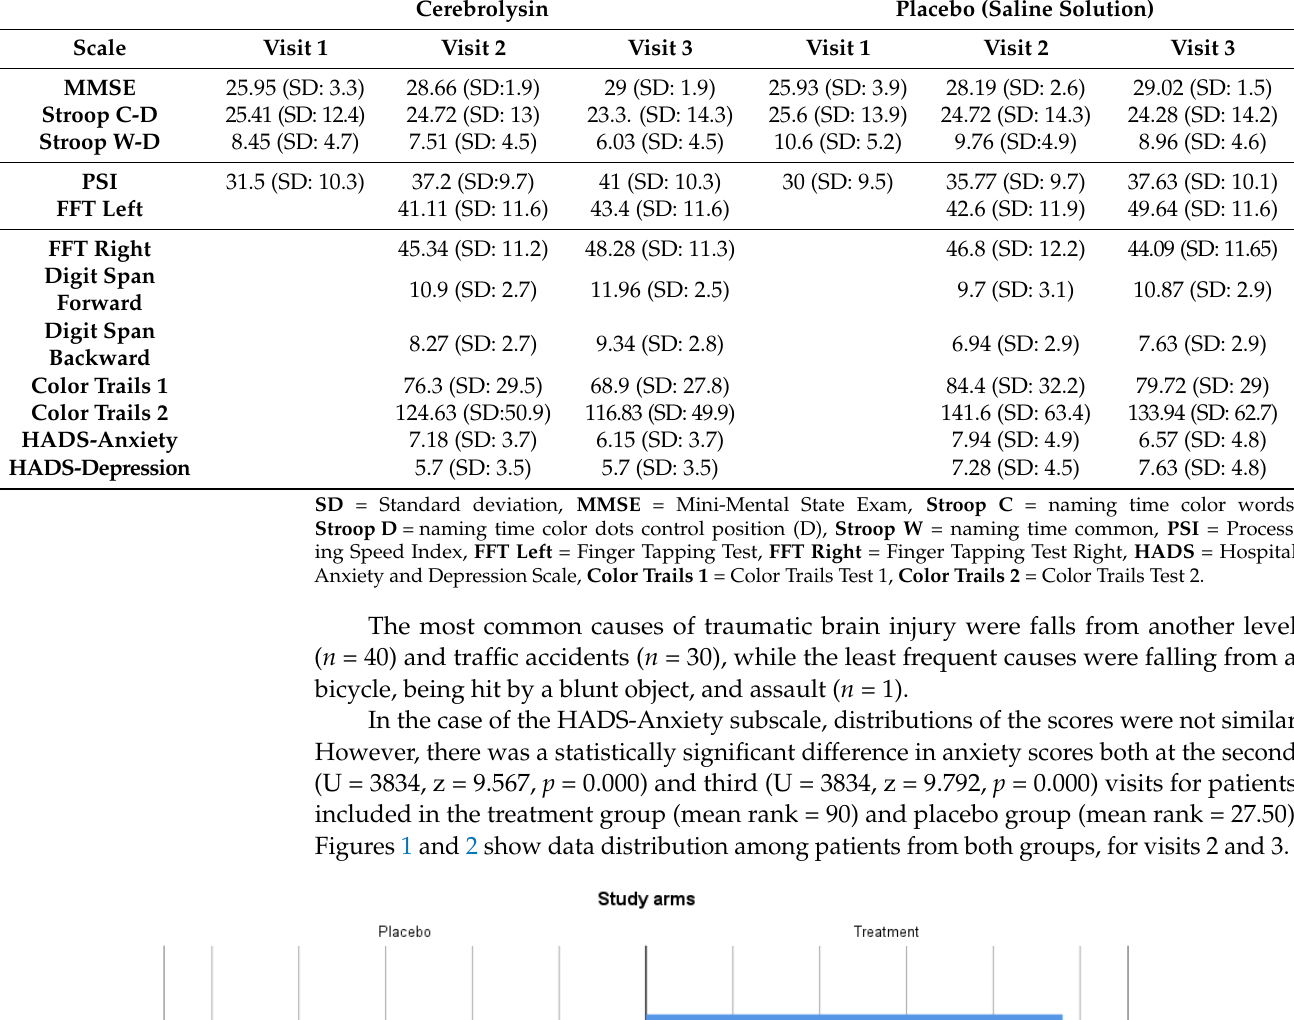
Table 5. Means and SDs of outcome scales across study visits and treatment groups. Cerebrolysin